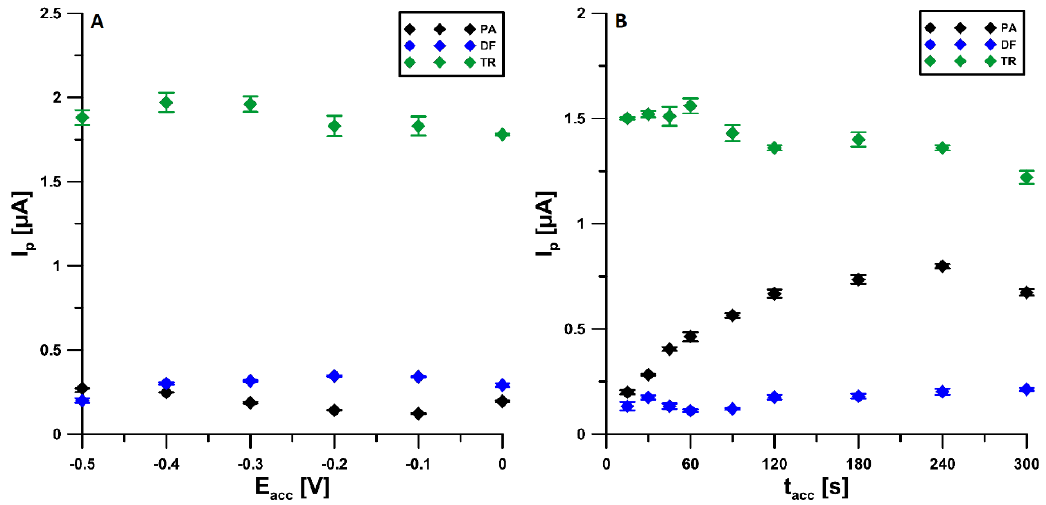
Figure 6. Influence of E acc. ( A ) and t acc. ( B ) on voltammetric response of 2 × 10 − 6 mol L − 1 PA, 1 × 10 − 7 mol L − 1 DF, and 1 × 10 − 5 mol L − 1 TR. The DPAdSV parameters: ∆ E A of 50 mV, t m of 50 ms, and ν of 140 mV s −1 .